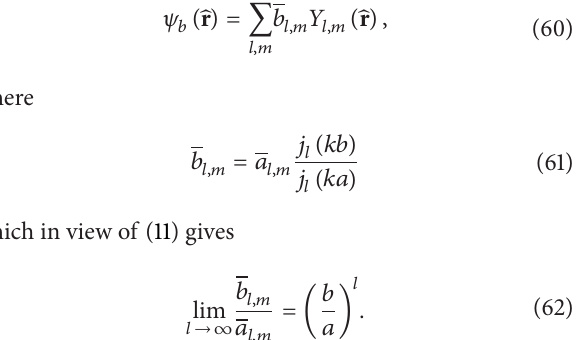
Figure7:Illustrationoftheminimumconvexsourceregion 𝐵 min , Figure 9: Backpropagation of the field at the sphere of radius 𝑟 = conv 𝑏 to the respective field at a larger concentric sphere. This process corresponding to the minimum source region 𝑉 min in Figure 6. The , and this radiated field can be estimated everywhere outside 𝐵 min , breaks down at the critical radius 𝑅 int min which defines the sought- conv information can be used subsequently to estimate the critical radius after boundary of the minimum source region 𝑉 min 𝑅 int min of the largest sphere up to which the known radiated field can be backpropagated, which establishes a boundary for the minimum source region 𝑉 min . The geometry of this backpropagation pierces , allowing the extraction or intersects concave portions of 𝐵 min , conv of the pending nonconvex support information of 𝑉 min that is not . contained in 𝐵 min , conv